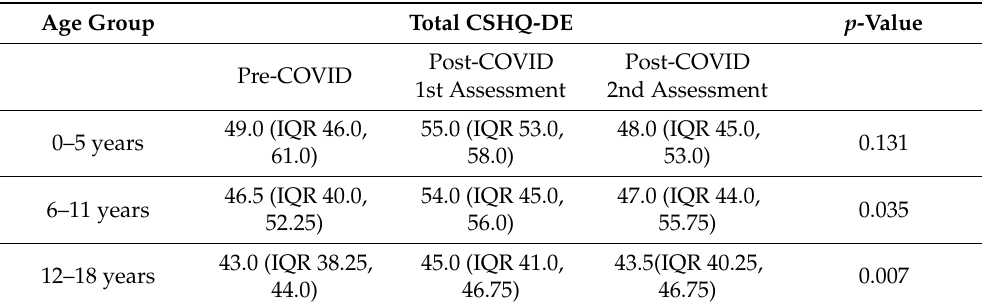
Table 4. Subgroup analysis of the CSHQ-DE score differentiated by age group (two-sided ANOVA (Friedman)).